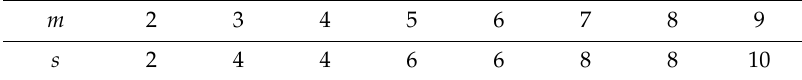
Table 1. Numerical convergence order of the algorithm using the m points Gauss–Legendre quadrature rule and m equidistant control points in constrained system. m 2 3 4 5 6 7 8 9 s 2 4 4 6 6 8 8